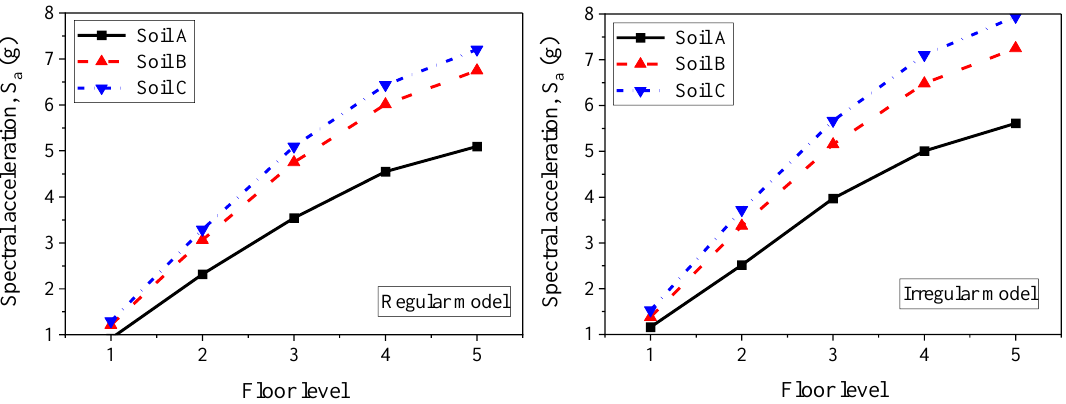
Figure 7. Peak floor spectral acceleration for different soil types with respect to 1st modal time period.